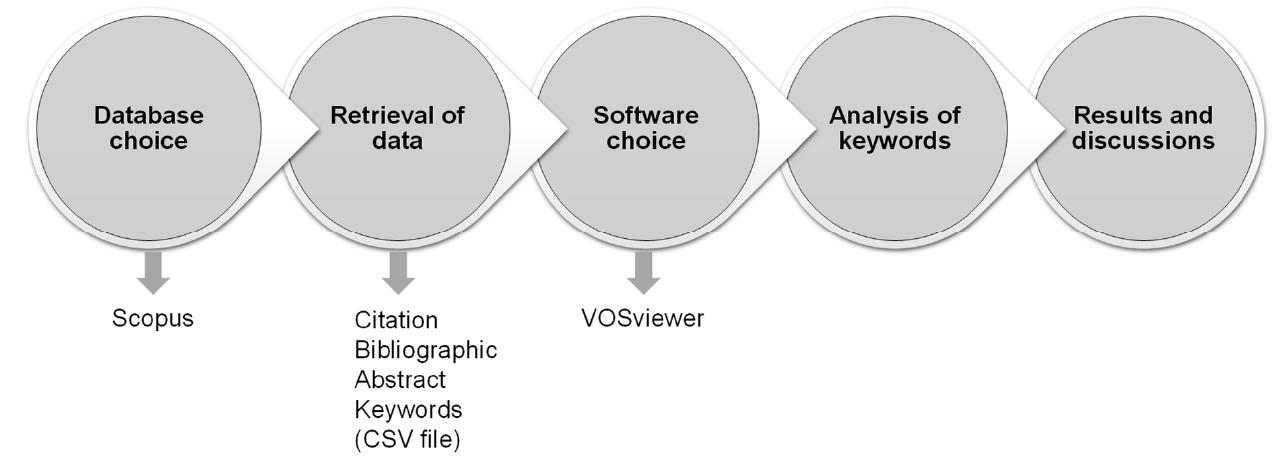
Figure 2. Sequence of the procedure followed for keywords’